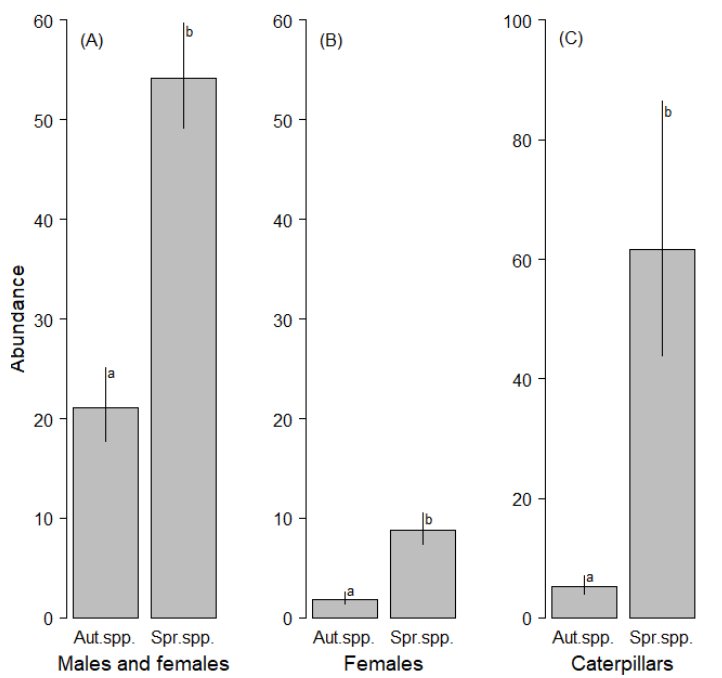
Figure 1. Abundance of winter geometrid moths (adults and caterpillars) on oak trees in Central Europe (Slovakia). ( A ) Males and females trapped per 1 dm of trunk perimeter at breast height (nc = 45, cs = 2); ( B ) females stuck per 1 dm of trunk perimeter at breast height (nc = 45, cs = 2); and ( C ) caterpillars per 1 m branches in length (nc = 23, cs = 2). Bars denote the mean abundance of moths or caterpillars; vertical lines show the 95% confidence intervals (CIs) for the means. Di ff erent letters above the CIs indicate significant di ff erence. Aut. spp., ‘autumn species’; Spr. spp., ‘spring species’; nc, number of clusters; cs, cluster